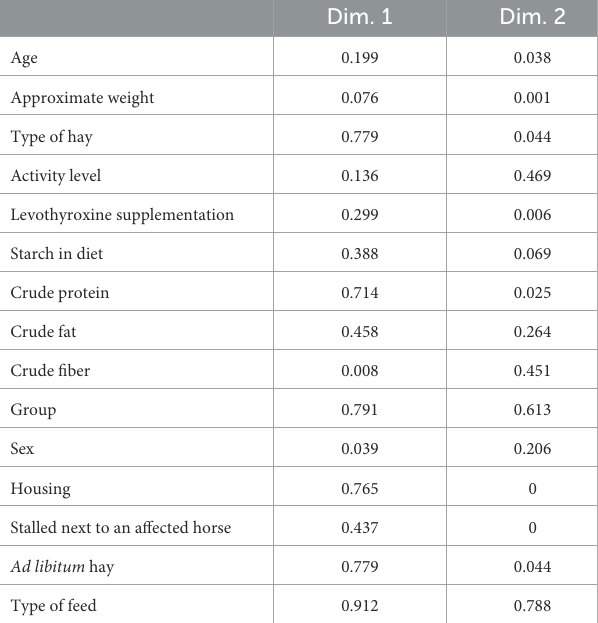
TABLE 6 Factor loadings for the first two dimensions from